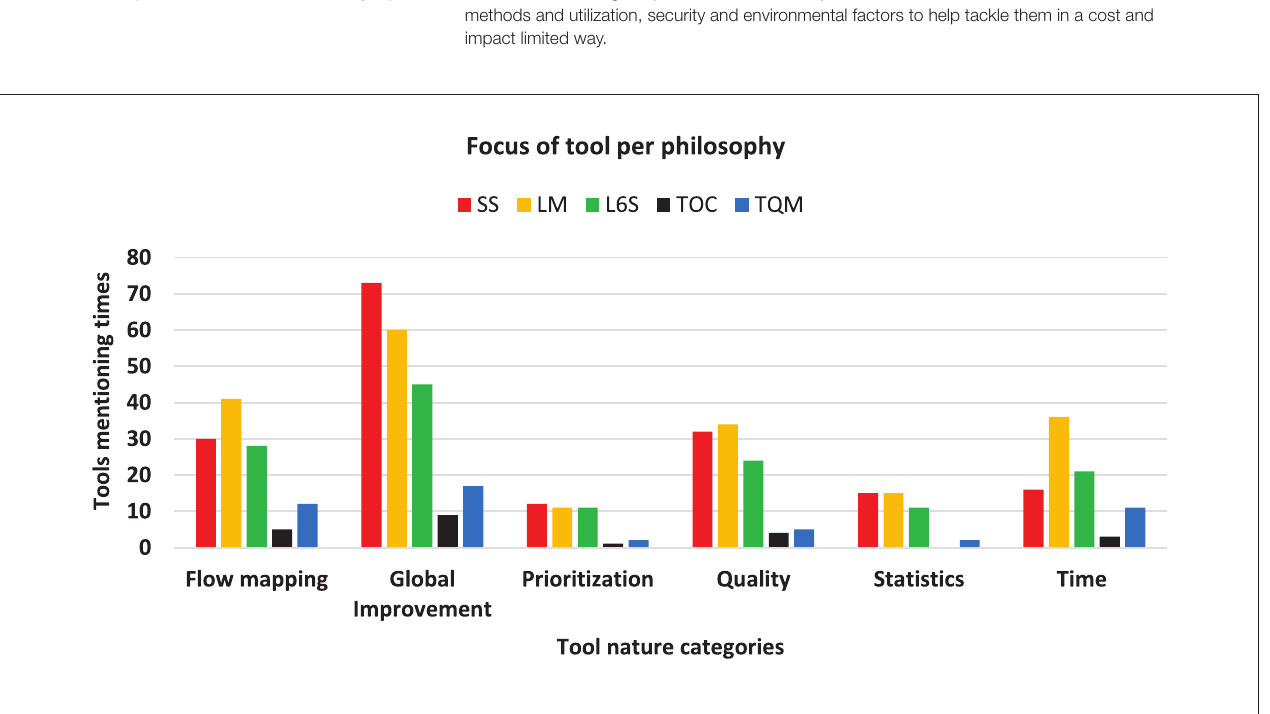
FIGURE 3 | Distribution of the mentions for the focus of the tools for each philosophy.